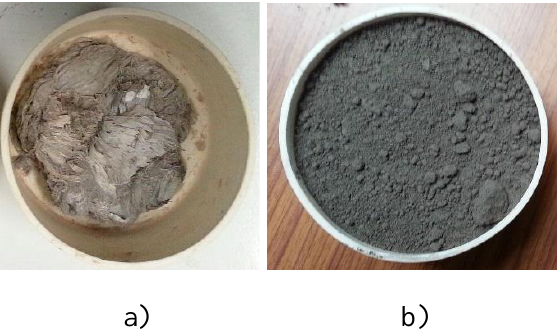
Figure 2. Areca nut husk ash: a) after muffle burning, b) after grinding and sieving Filtration unit Filtration is the separation of suspended solid particles from a liquid by forcing the latter to flow through the pores of another